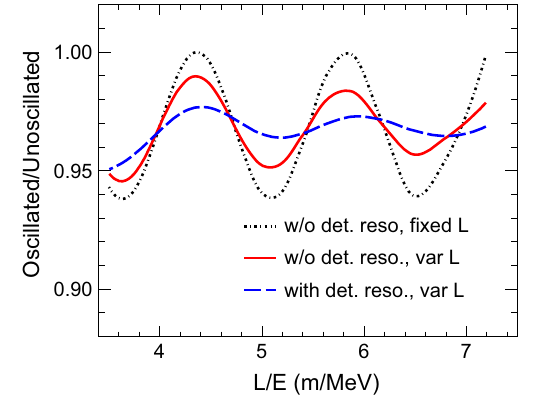
Fig. 3 Ratios of oscillated to unoscillated event distribution as a func- tion L / E . Oscillated events are estimated with Δ m 2 sin 2 2 θ 14 =0.062.Theblackdottedlineshowstheratiosinidealcasei.e. without incorporating the detector response and at a fixed path length of 13m. The red solid line shows the events ratios by considering a cylindrical reactor core (parameters mentioned earlier) without incor- porating the detector resolution and the same with detector resolution is shown in blue dashed